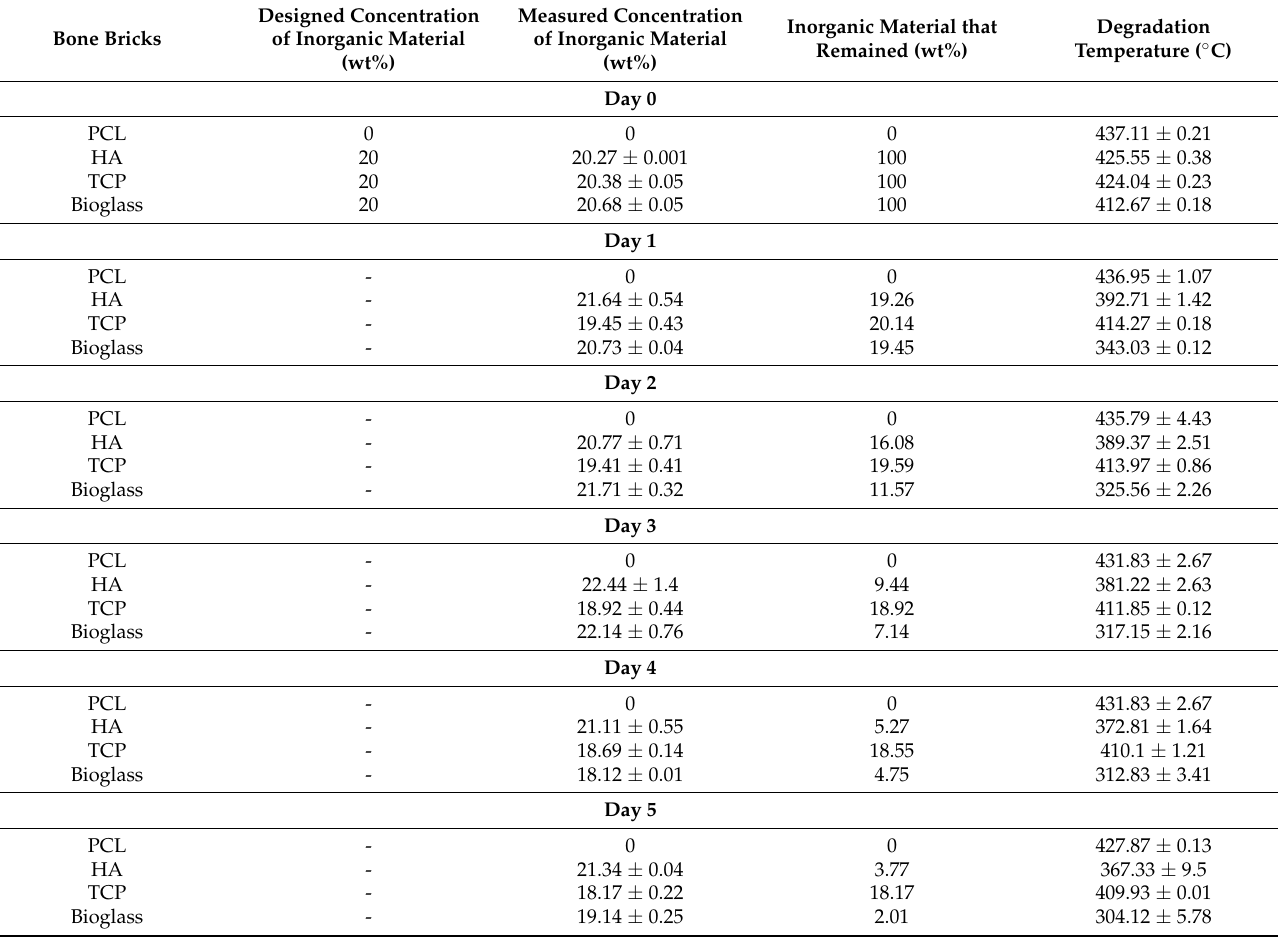
Table 5. Designed and printed concentrations of PCL, HA, TCP and bioglass on the bone bricks and corresponding variations at different degradation time